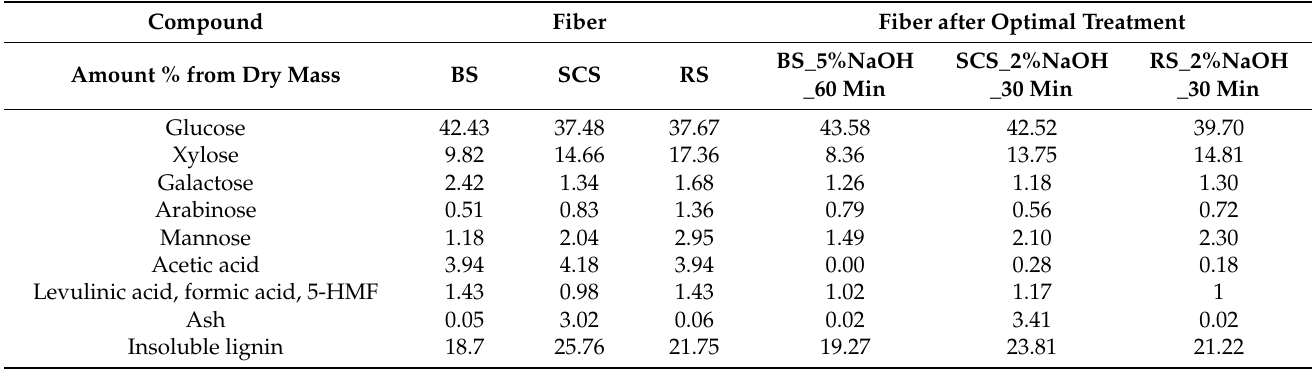
Table 2. Chemical compositions of untreated and treated BS, SCS, and RS